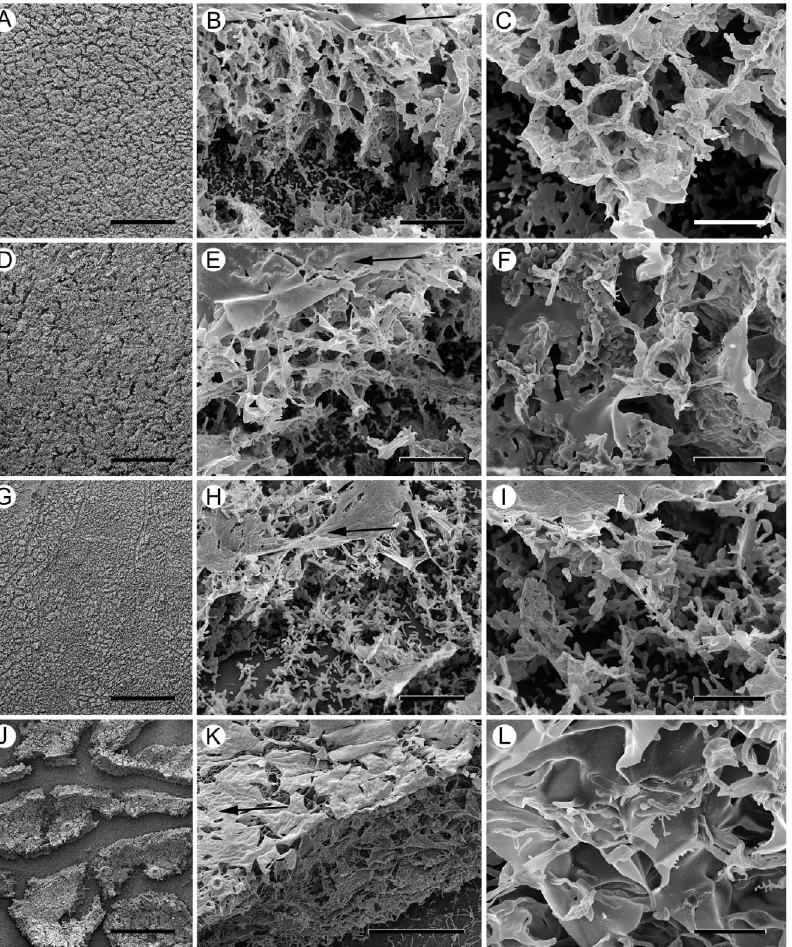
Figure 6. Sub-inhibitory concentrations of ampicillin change the ultrastructure of newly formed NTHi biofilms. Scanning electron microscopy (SEM) images comparing NTHi biofilms formed in the absence and presence of ampicillin on Thermanox coverslips. A–C: SEM of 2019 biofilms. A) At low power the 2019 biofilm is seen as a mat covering the Thermanox substrate. Bar=500 m m. B) higher magnification shows the biofilm to be composed of partitions forming empty spaces, or cells, covered with a film of amorphous material (arrow). Bar=10 m m. C) the partitions within the biofilm are composed primarily of bacterial cells aggregated into flat sheets. Bar=5 m m. D–F: SEM of 2019 biofilms formed in 90 ng/mL ampicillin. D) The 2019 biofilm formed with ampicillin covers the substrate. Bar=500 m m. E) The biofilm is composed of partitions around empty spaces with a flat sheet of amorphous material (arrow) over the top. Bar=50 m m F) The biofilm partitions are composed of aggregated bacteria embedded in sheets of amorphous material. Bar=5 m m. G–I: SEM of PittGG biofilms. G) The PittGG bacteria form a biofilm over the Thermanox surface. Bar=500 m m. H) The biofilm is composed of bacterial cells aggregated into poorly defined partitions and covered with a layer of amorphous material (arrow). Bar=10 m m. I) The biofilm is composed of bacterial cells aggregated into widely spaced strands, and empty space. Bar=5 m m. J–L: SEM of PittGG biofilms formed in 170 ng/mL ampicillin. J) In the presence of ampicillin the PittGG bacteria form a biofilm comprised of a thick mat, which appears to be strongly attached to itself but less well attached to the substrate. Bar=500 m m. K) The biofilm mats appear to be composed mostly of amorphous material, a layer of which covers the biofilm (arrow), and arranged into tightly-packed thin partitions. Bar=50 m m. L) the biofilm is composed of amorphous material formed into thin partitions. The few bacteria detected were embedded in the thin partitions. Bar=5 m